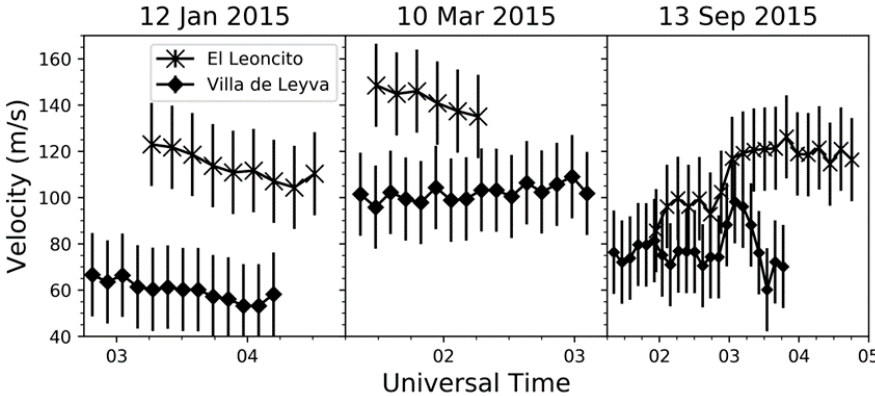
Figure 10. Zonal velocities calculated on three different nights at Villa de Leyva (diamond) and El Leoncito (cross). Heights used for El Leoncito (Villa de Leyva) were 300, 250, and 260 km (240, 230, and 250 km) for 12 January 2015, 10 March 2015, and 13 September 2015, respectively. Higher zonal drifts are measured in the southern hemisphere.